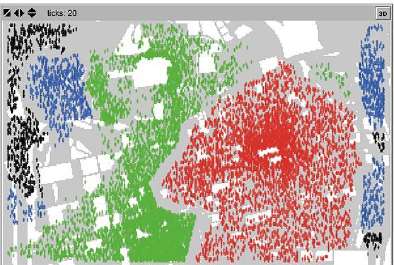
Figure 10-2: Segregation pattern at a satisfaction level of 70% and radius 10